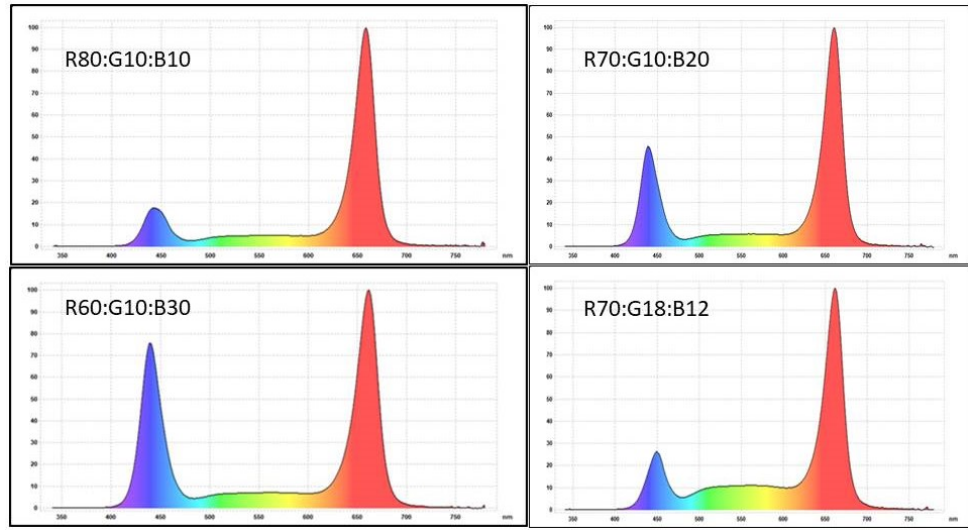
Figure 1. Spectral photon flux distribution for the 4 LED light treatments in vertical cultivation of romaine lettuce; fraction of integral photon flux ranging from 340 to 780 nm in red R 600–699 nm, green G 500–599 nm, and blue B 400–499 nm ( Y -axis—relative values from 0 to 100%).